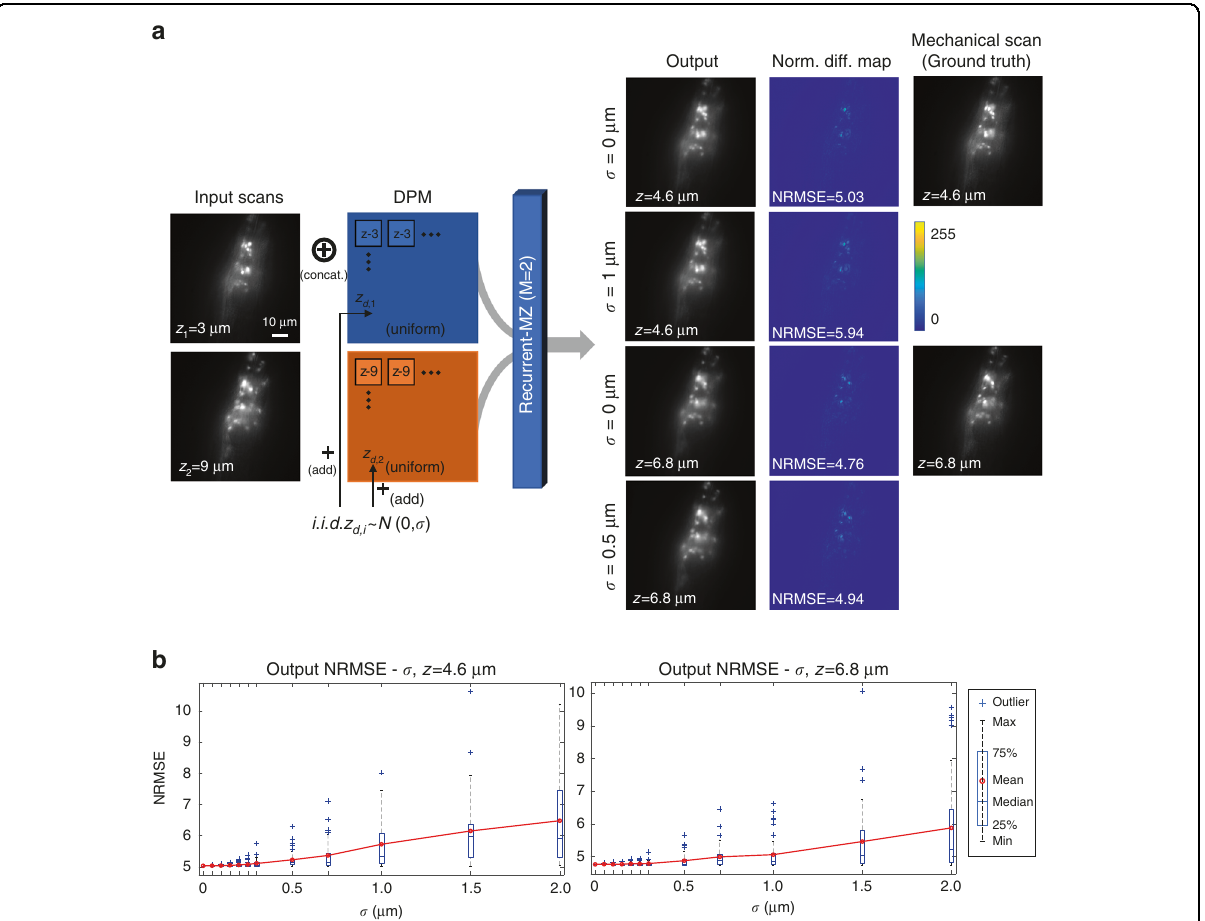
Fig. 5 Stability test of Recurrent-MZ inference. a An additive Gaussian noise with zero mean and a standard variance of σ was injected into each DPM to test the stability of Recurrent-MZ inference. The output images and difference maps (with respect to ground truth) with no injected noise ( σ = 0) and with different levels of noise injection are shown. b The NRMSE- σ boxplots for Recurrent-MZ output images at z = 4.6 μ m and z = 6.8 μ m are reported. NRMSE values were calculated over 50 random tests. The difference maps were normalized by the maximum difference between the input images and the ground